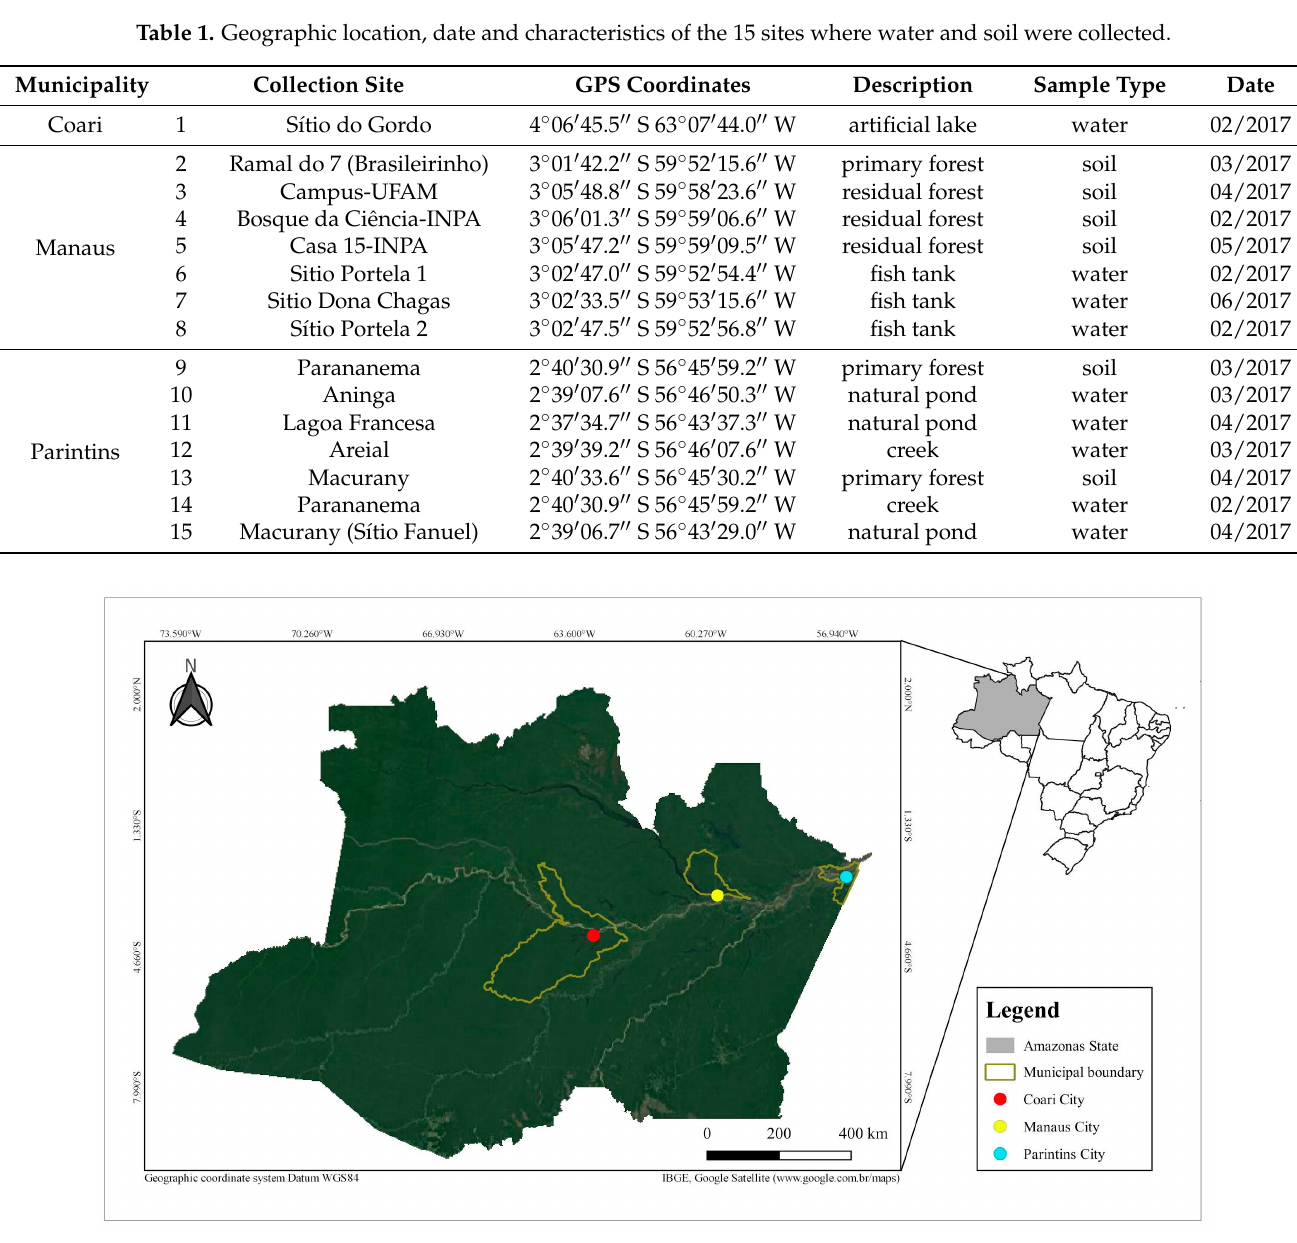
Table 1. Geographic location, date and characteristics of the 15 sites where water and soil were collected. Municipality